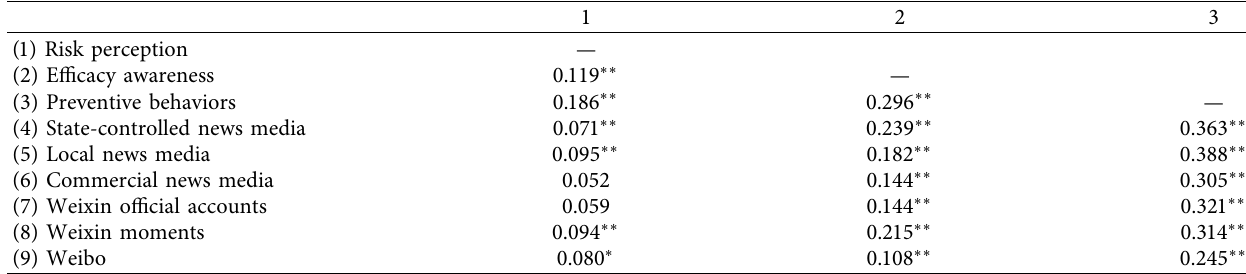
Table 10: Relationship between the frequency of the audience’s exposure to COVID-19 vaccine information through news media platforms and their COVID-19 risk perception, vaccine efcacy awareness, and preventive behaviors.